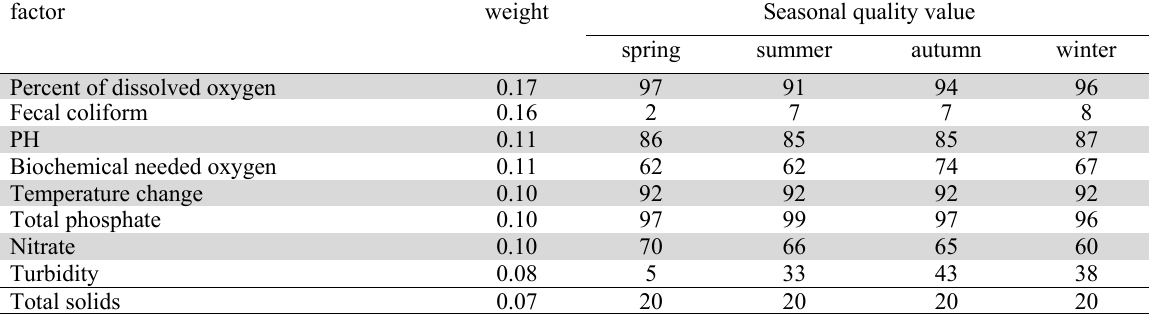
Biochemical needed